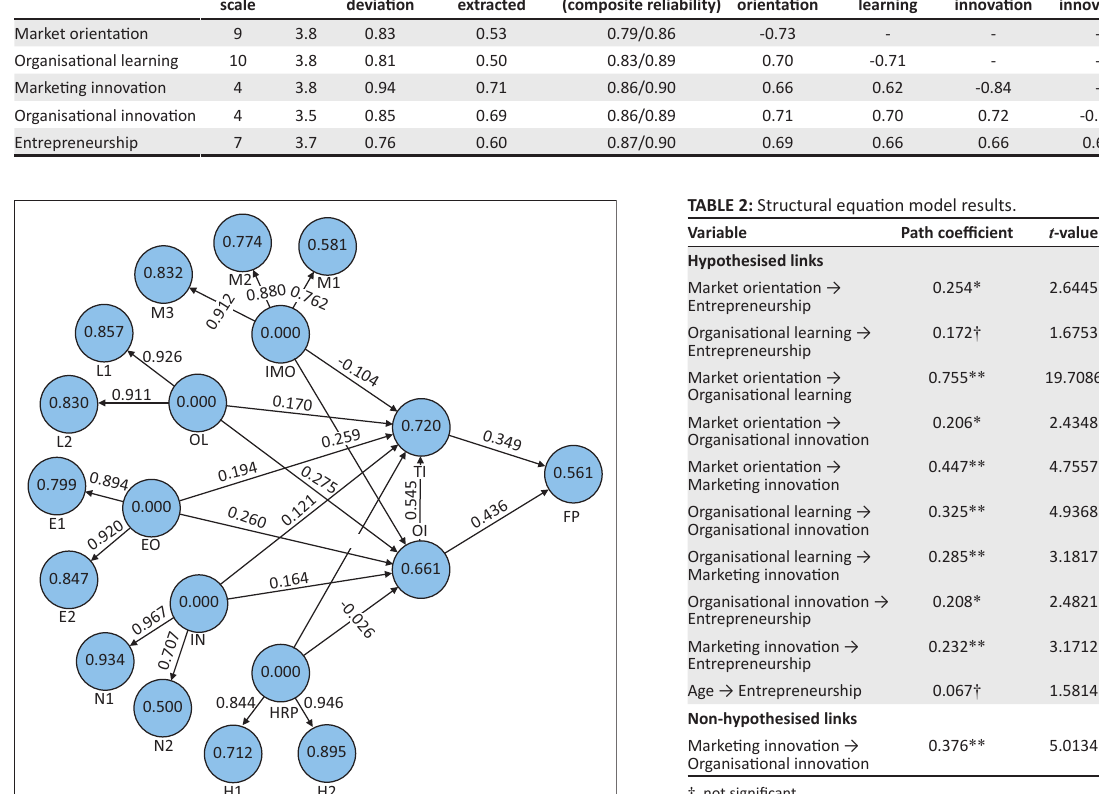
TABLE 1: Measurement model results ( N = 155). Construct